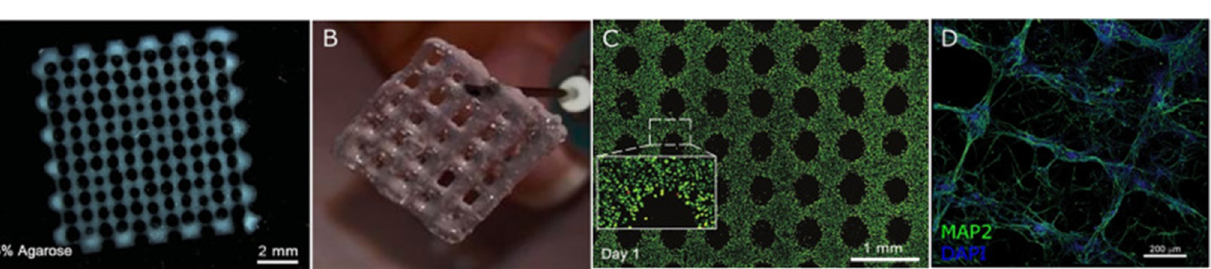
Table 1. Recent in vitro studies using bio-scaffolds for nerve injury repair.